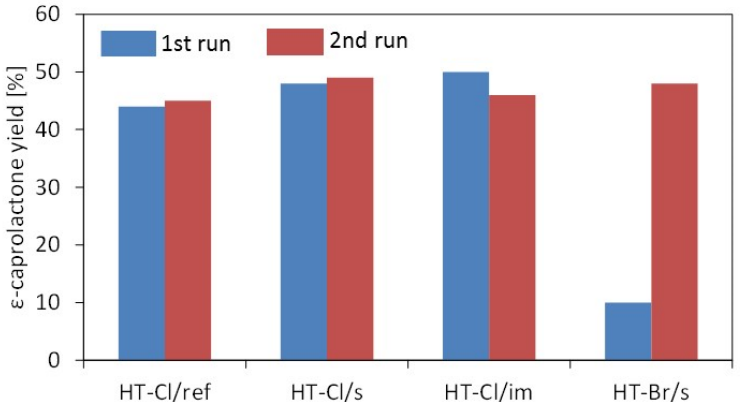
Figure 9. Recycling experiments over chloride forms of HT catalysts in the presence of NaHCO 3 .